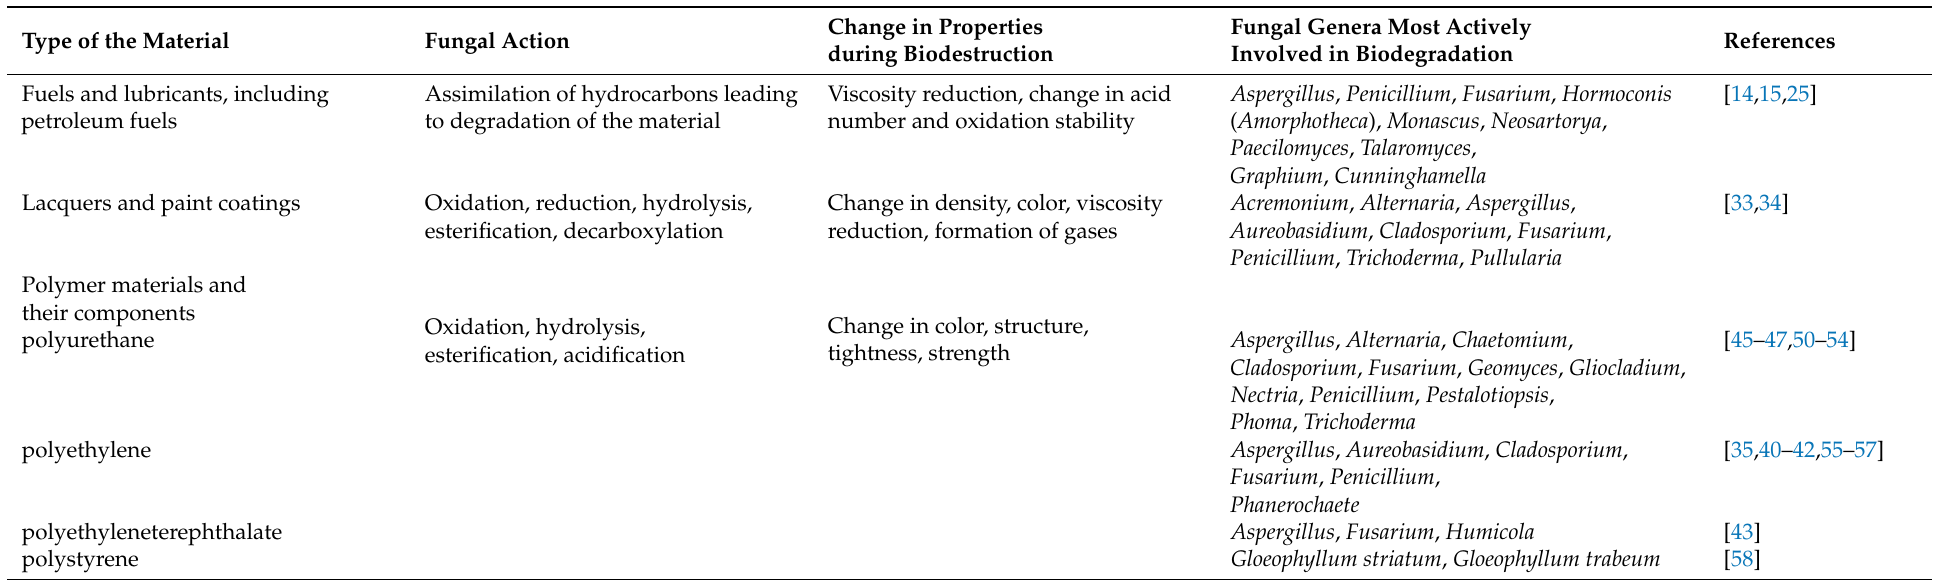
Table 1. Degradation of some industrial materials by